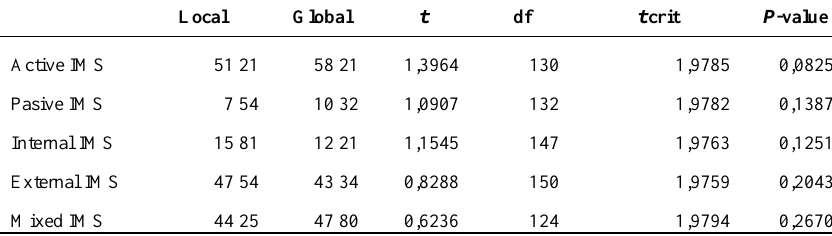
Table 8. t -test, average ideas created - apply type comparison by IMS type